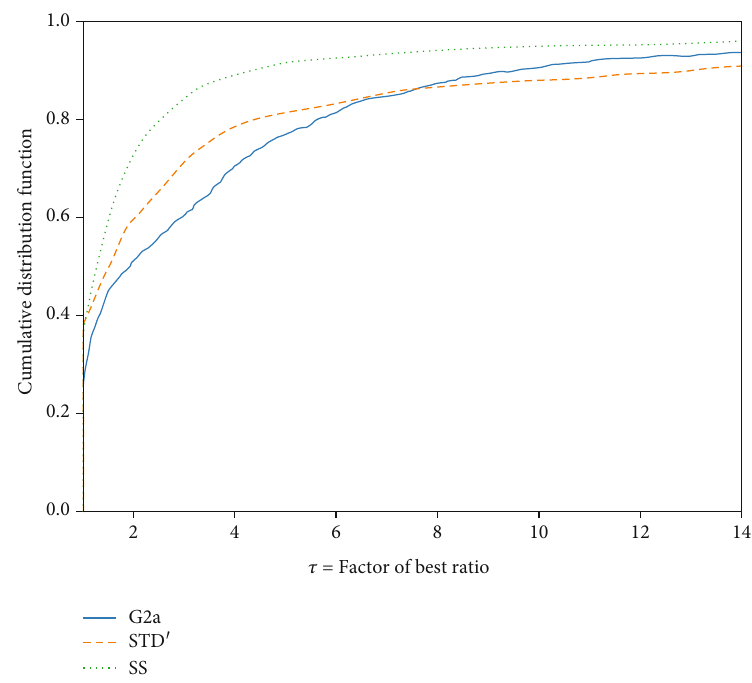
Figure 11: Performance pro fi les based on relative CPU time (s) over all problem